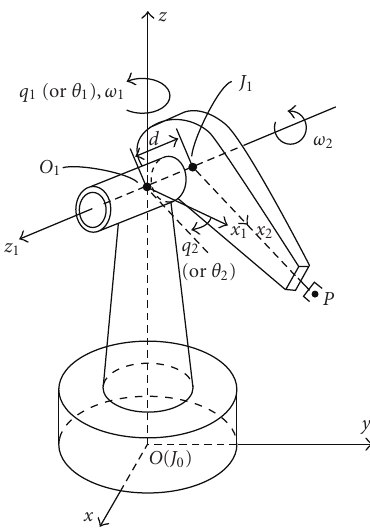
Figure 1: A 2-DOF part of vertically revolute robot